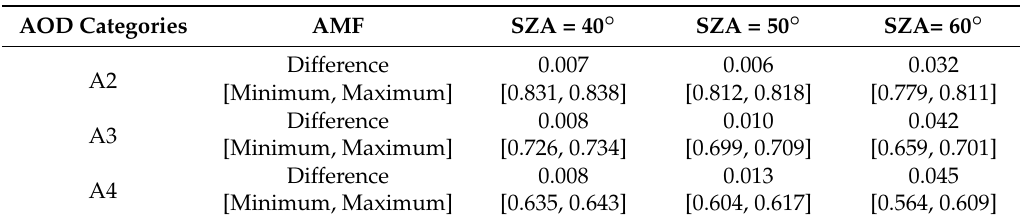
Table 7. The maximum and minimum values of theoretical AMFs and its spectral difference within the spectral range from 300 to 360